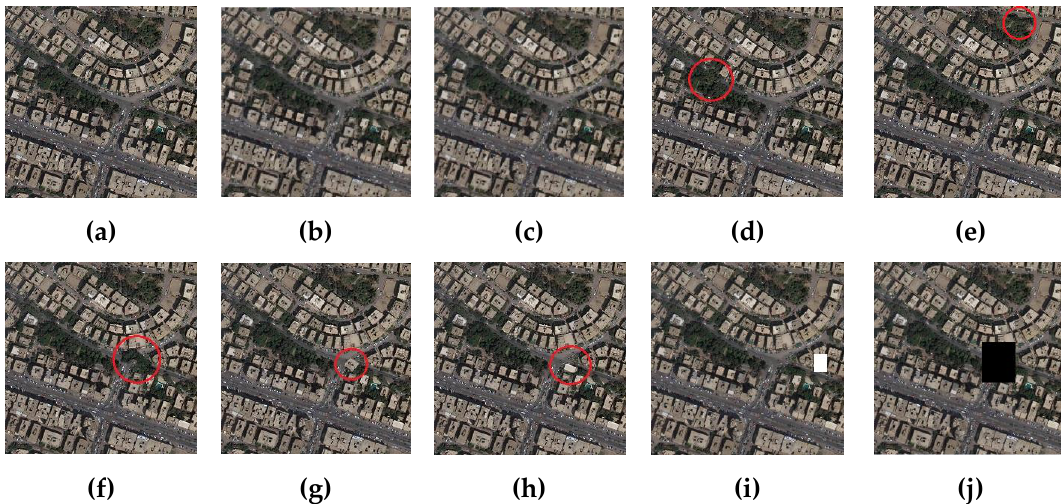
Figure 9. A set of HRRS image integrity authentication examples: ( a ) The original HRRS image (TIFF format); ( b ) lossy compressed image; ( c ) noise added pictures; ( d – f ) subject unrelated tampering one-three; ( g – j ) subject related tampering